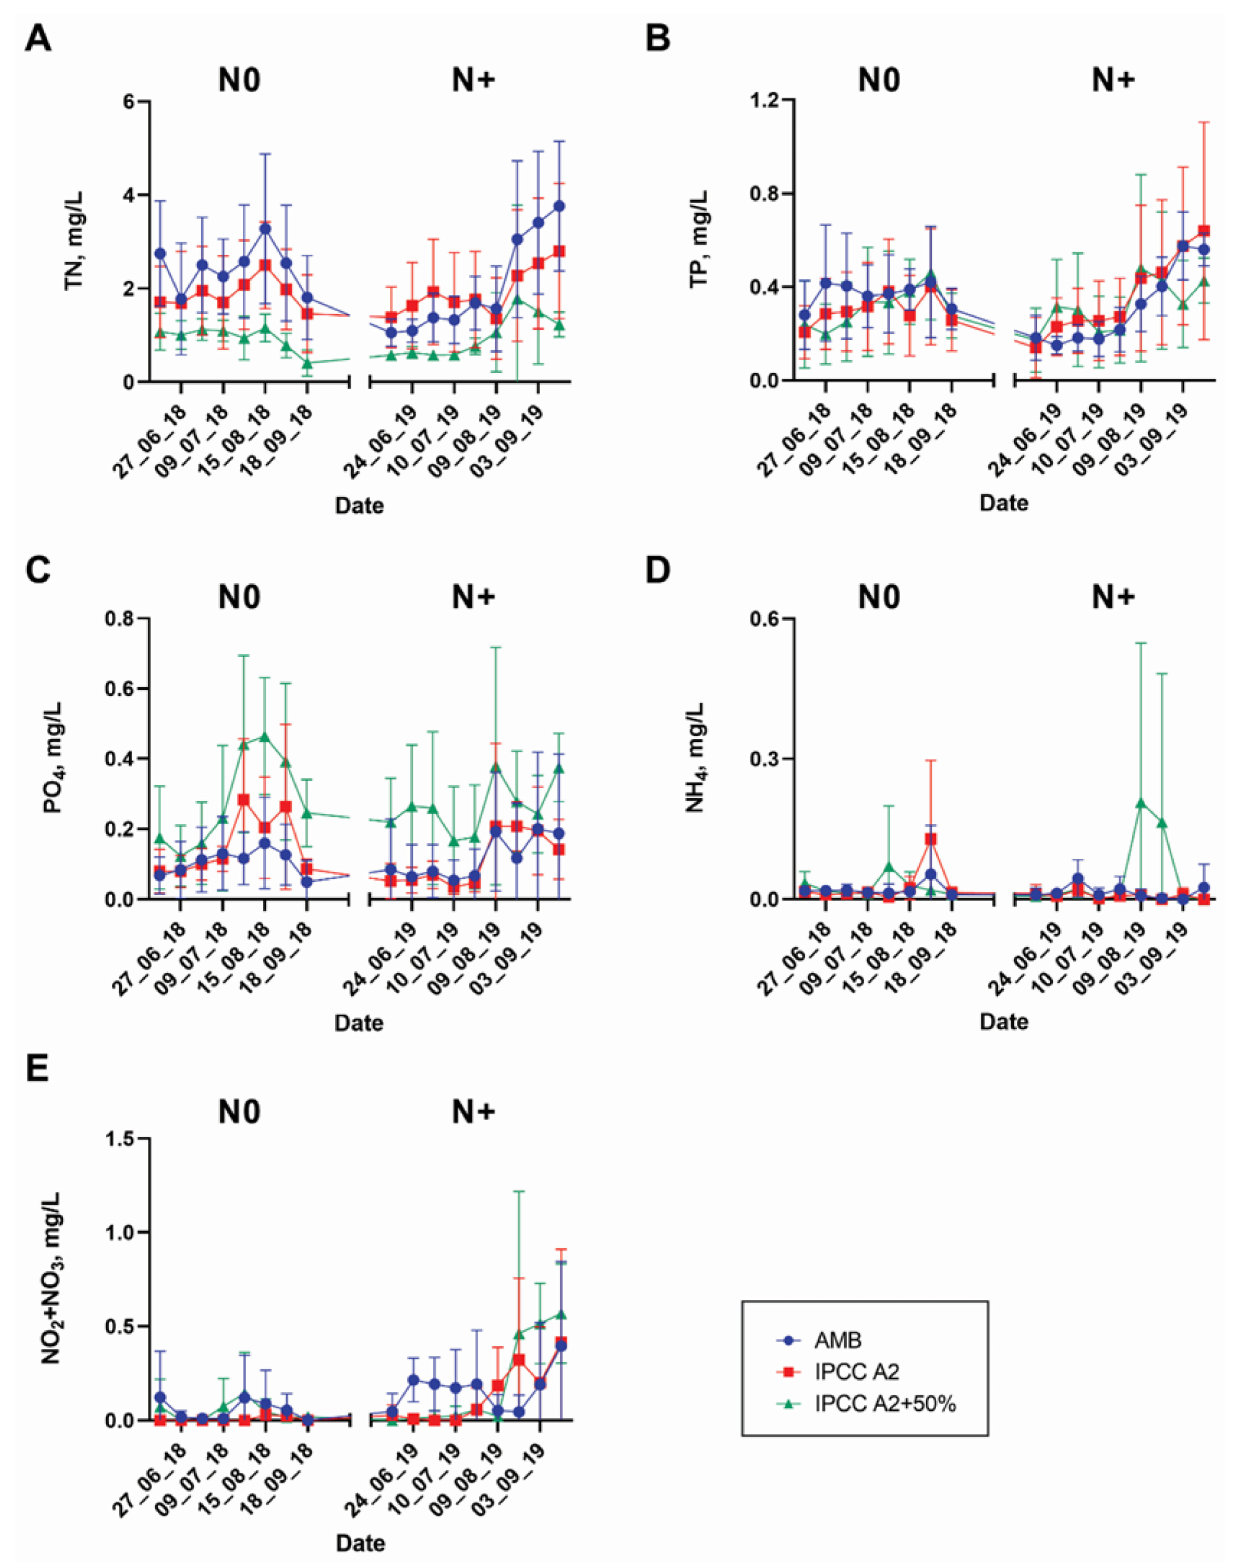
Figure 3. Variations in nutrients from mid-June to September during the N0 and N+ periods: ( A ) TN; ( B ) TP; ( C ) PO 4 ; ( D ) NH 4 ; ( E ) NO 2 + NO 3 . Bars—SD of the